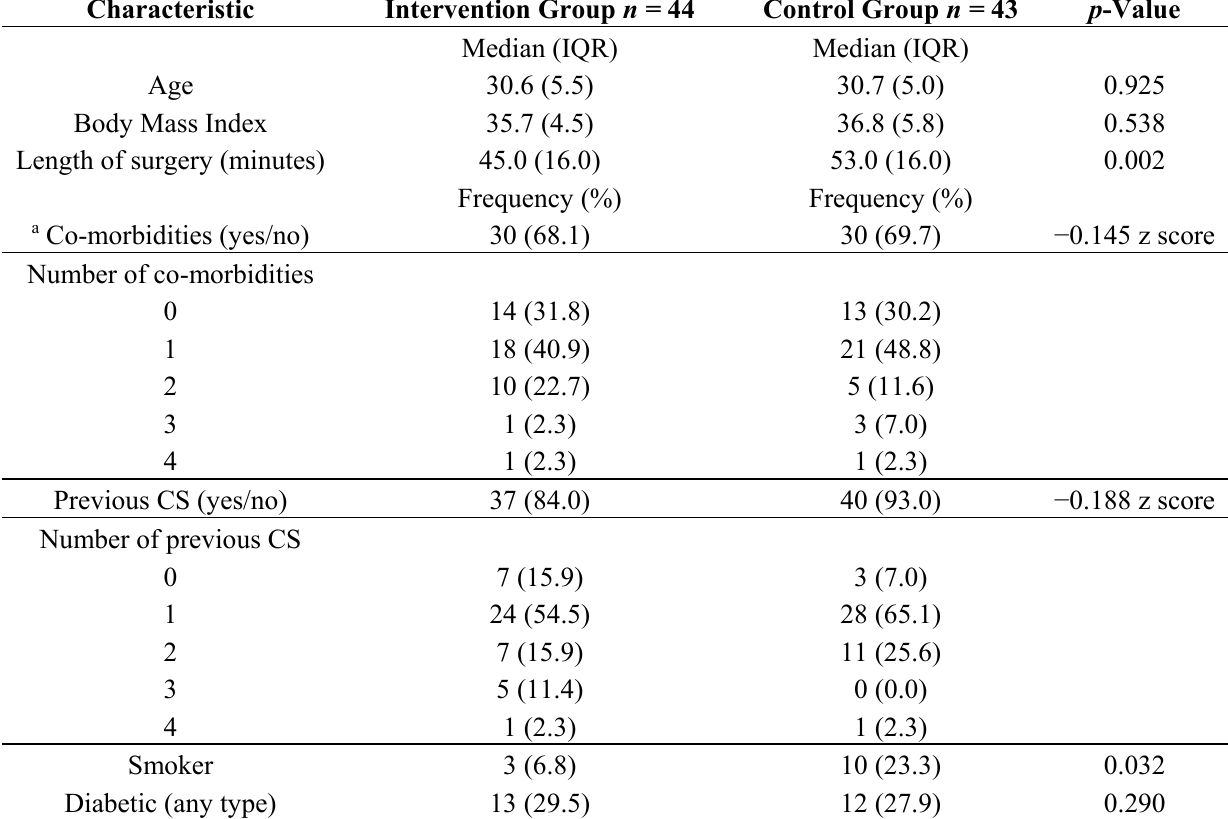
Table 1. Characteristics of the Sample ( n =